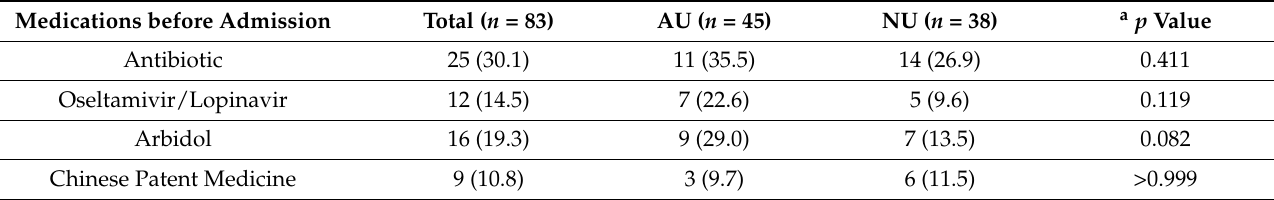
Table 3. Prehospital medications between AU and NU